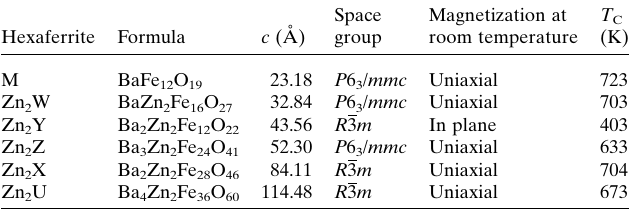
Table 1 Structural and magnetic characteristics of the M-type and Zn-containing